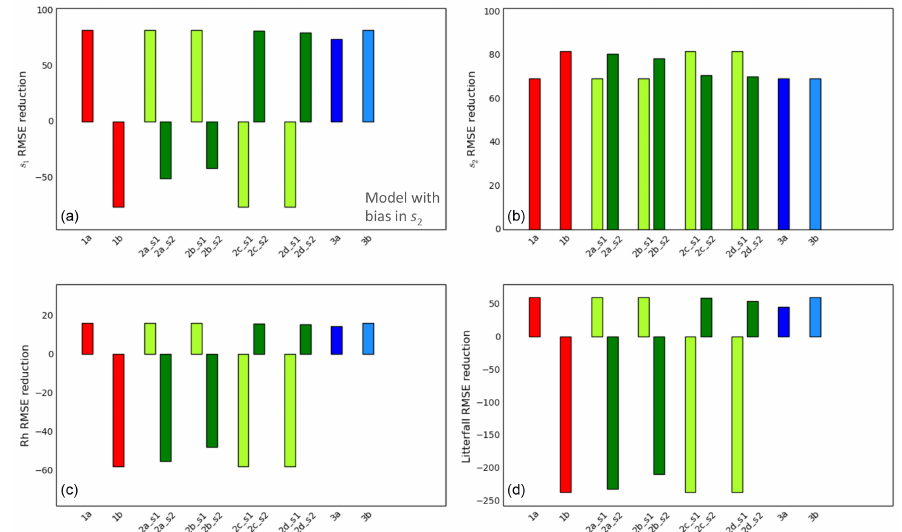
Figure 3. Reduction in RMSE for all test cases for simulations with a bias in the s 2 variable: (a) s 1 , (b) s 2 , (c) litterfall and (d) het- erotrophic respiration (Rh). For the step-wise cases (2a, b, c and d) the reductions after both step 1 and step 2 are shown in light and dark green, respectively, and are denoted in the x axis labels with “_s1” for step 1 and “_s2” for step 2. The reduction (in %) is calculated as 1 − (RMSE post / RMSE prior ).